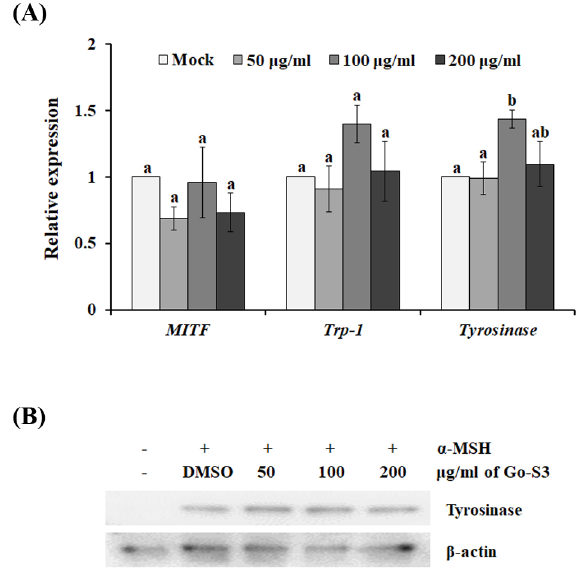
Fig. 4: Effect of Panax ginseng berry extract (Go-S3) on the levels of melanogenesis-related genes (A) and protein levels of tyrosinase (B) in α-MSH-stimulated B16F10 cells. The results shown in (A) were normalized to β-actin mRNA levels. (B) Total cell lysates were extracted and assayed by western blotting using antibody against tyrosinase. The value for the non-stimulated cells was set to 1.0. Values with the same letter are not significantly different as determined by Duncan’s multiple range tests.